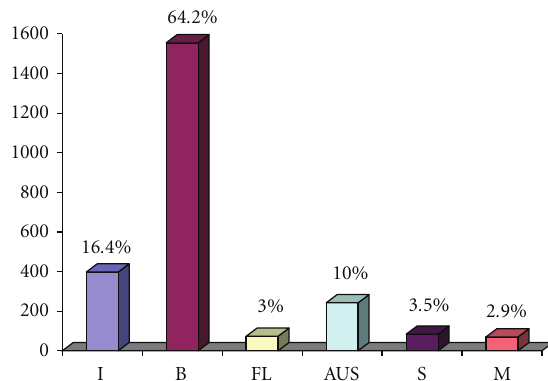
Figure 1: I: inadequate; B: benign; FL: follicular lesion; AUS: atypia of undetermined significance; S: suspiciousfor malignantneoplasia; M: malignant neoplasia. Distribution of cytological categories after